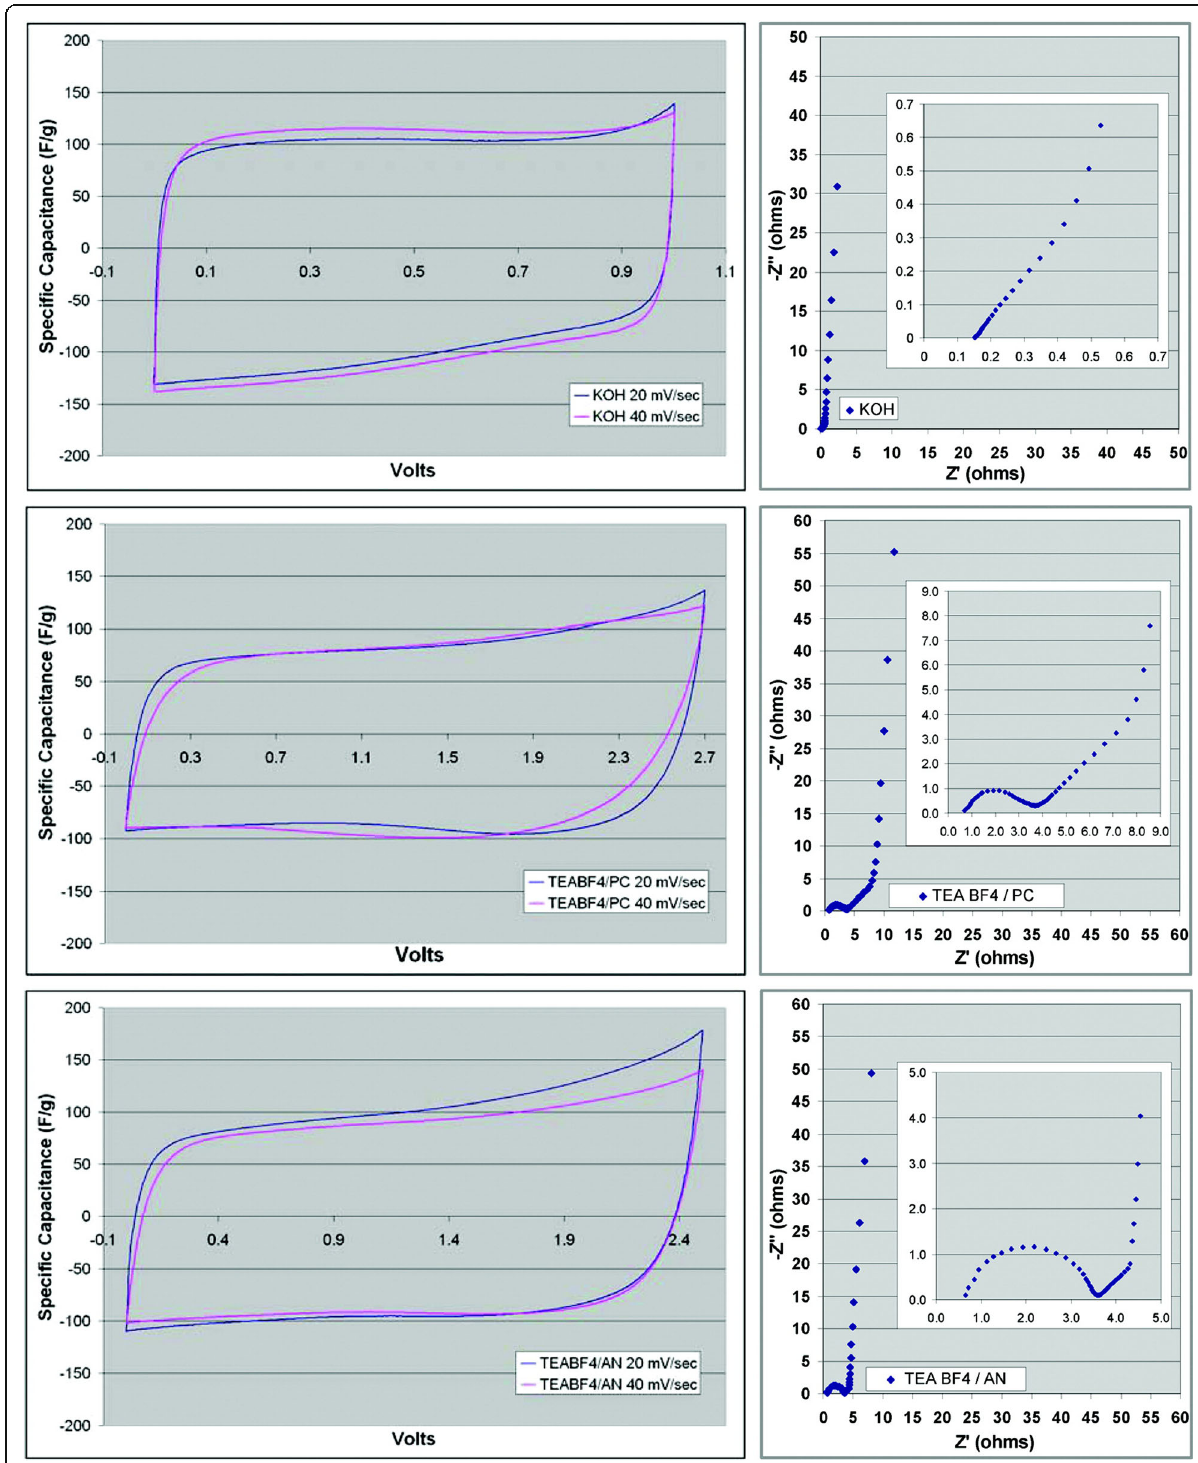
Fig. 3 CV ( left ) and Nyquist ( right ) plots of CMG material with KOH electrolyte ( top ), TEABF 4 in propylene carbonate ( middle ) and TEABF 4 in acetonitrile ( bottom ). Reprinted with permission from [24]. Copyright 2008 American Chemical